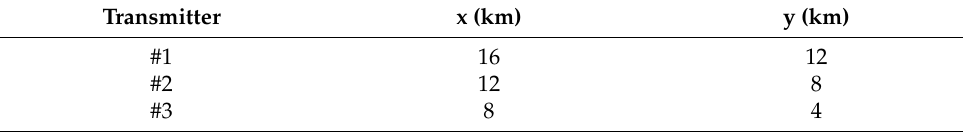
Table 8. Receiving antennas